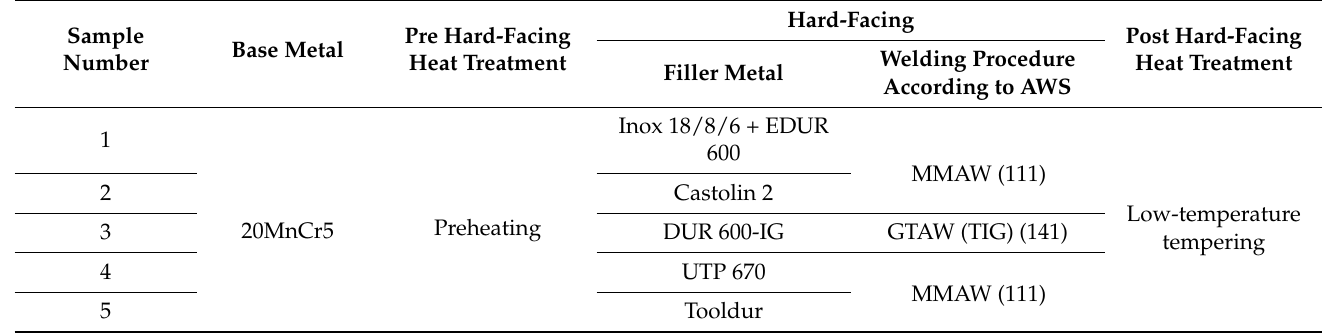
Table 2. Preparation technology of samples hard-faced by the “ hard ” filler metal .